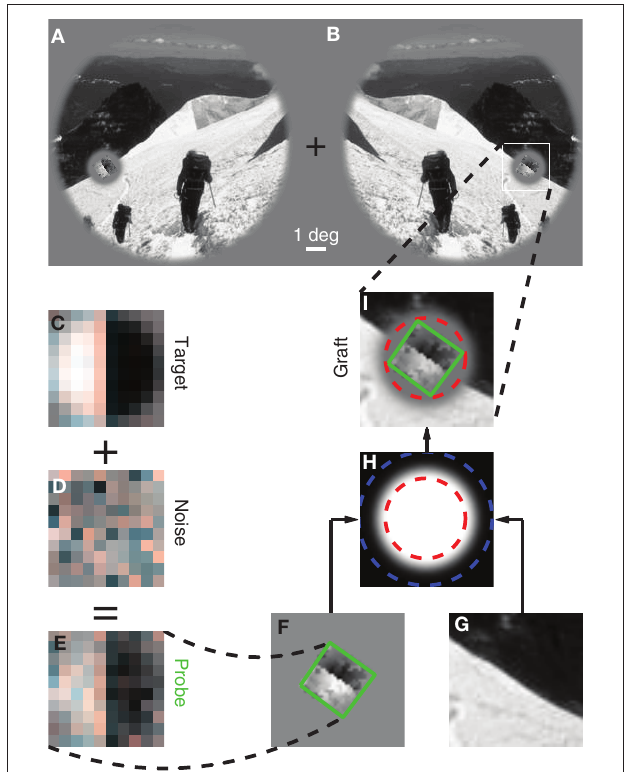
Figure 1 | Stimulus design and experimental protocol. Observers were asked to select one of two images ( A versus B ) that appeared to the sides of a central fixation cross. The target image [ (B) in this example] contained a grafted edge (indicated by the white square) that was aligned with the local characteristics of the picture (the mountain ridge in this example), the non-target image (A) contained a similar graft but oriented orthogonally to the local structure of the picture. We created the graft by smoothly inserting a probe (green outline) into the natural scene. The probe (e) consisted of a target edge (C) superimposed onto Gaussian noise (D) ; it was rotated (F) to match the local structure of the picture (g) and then inserted via a smooth envelope (H) . The envelope was designed so that the probe would be isolated from the natural scene within the resulting graft (i) . See Section 2.2 for